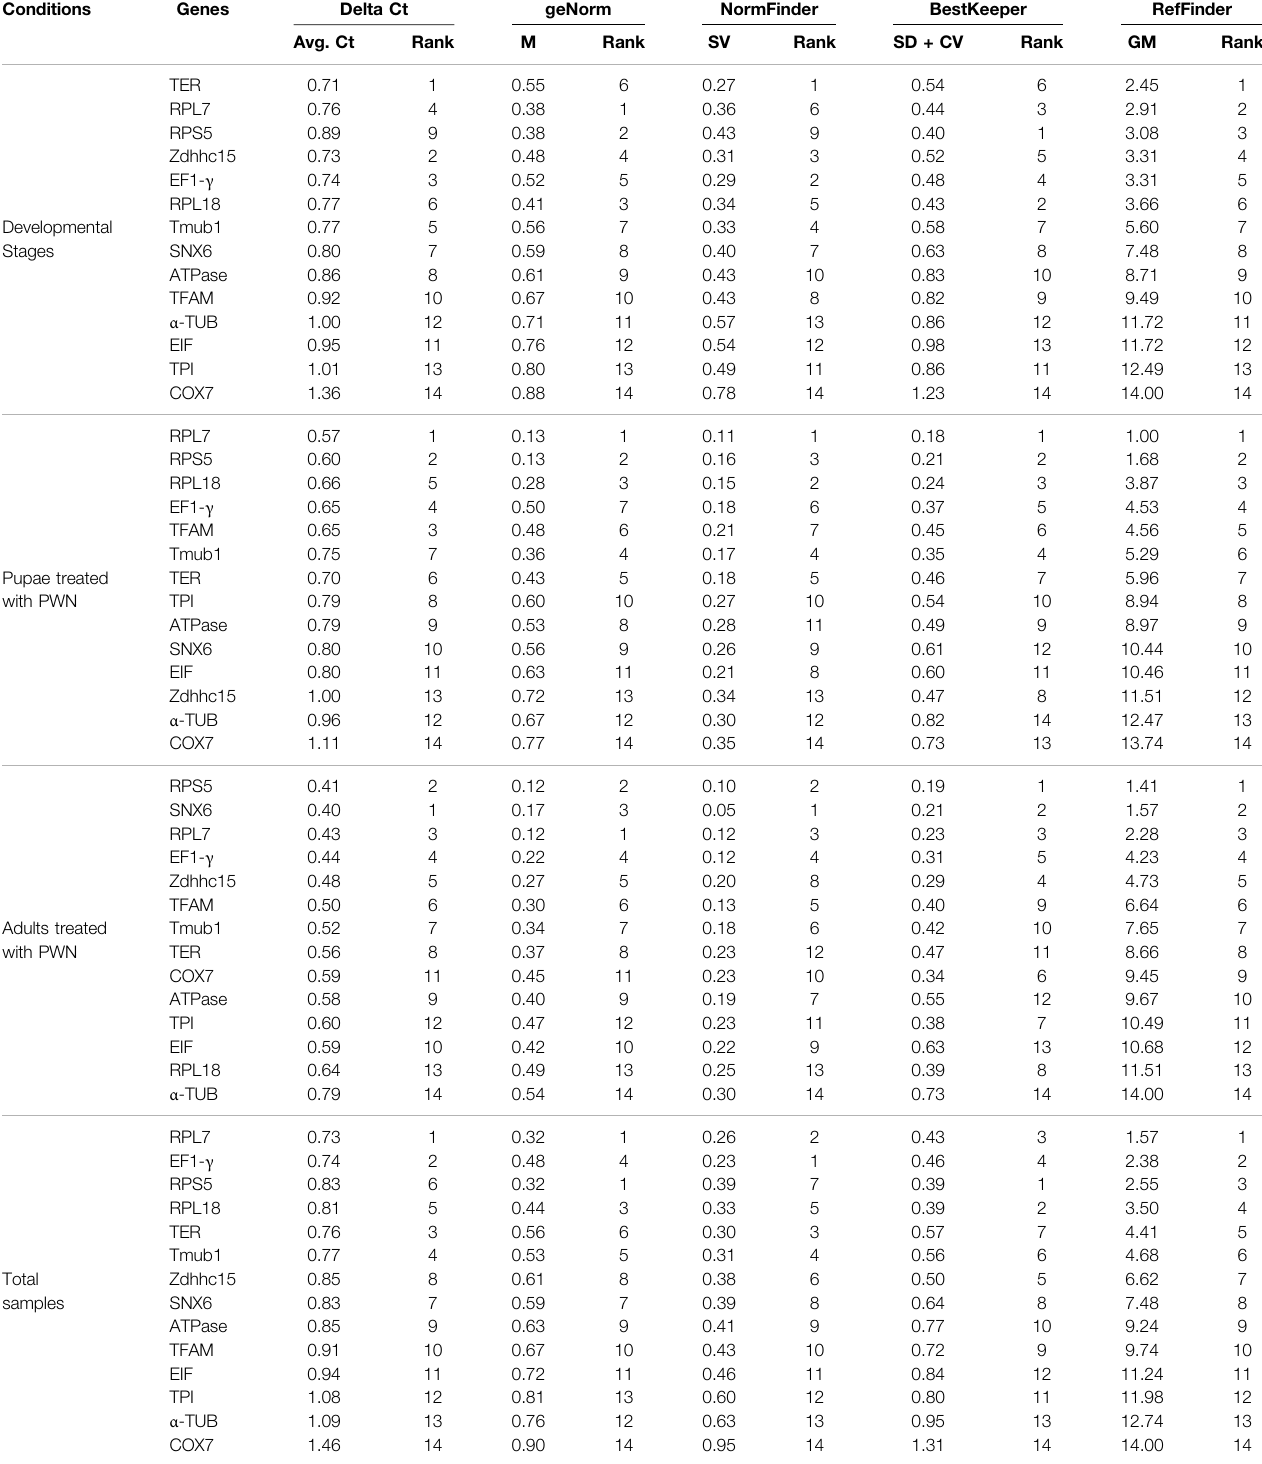
TABLE 2 | Expression stability ranking of the 14 candidate reference genes based on fi ve algorithms.